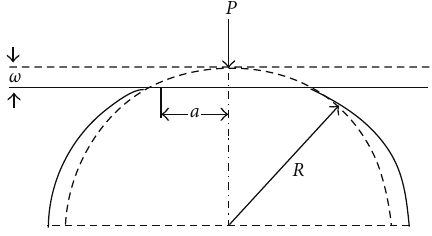
Figure 1: A deformable sphere pressed by a rigid